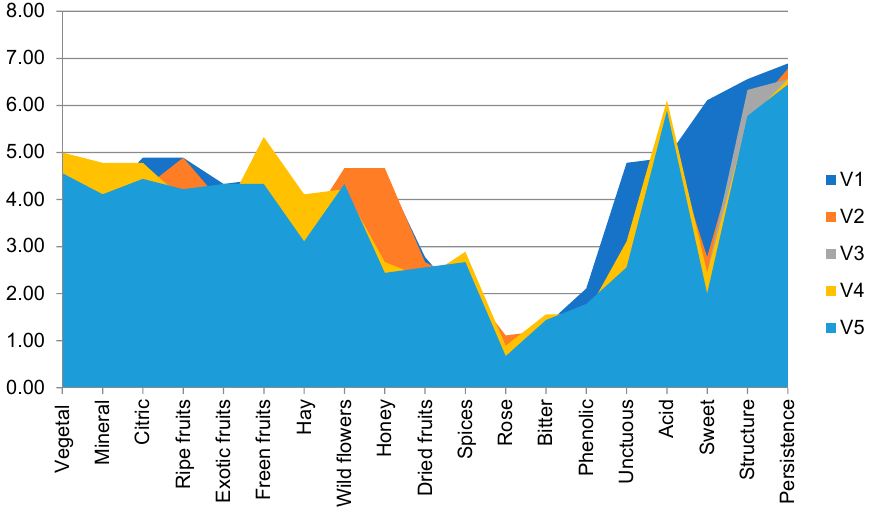
Figure 3. Sensory perception of analyzed samples.